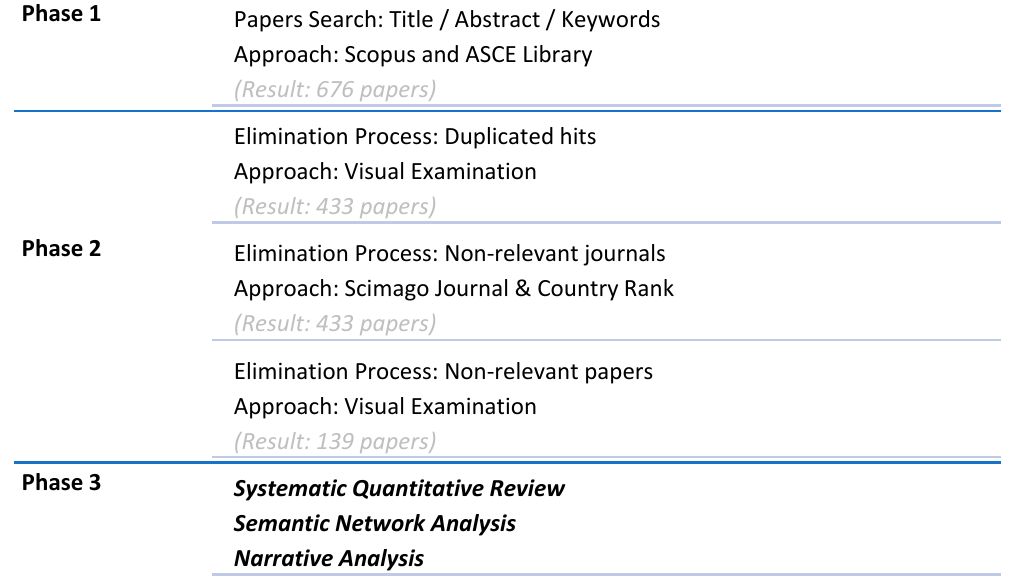
Figure 1. Research framework.